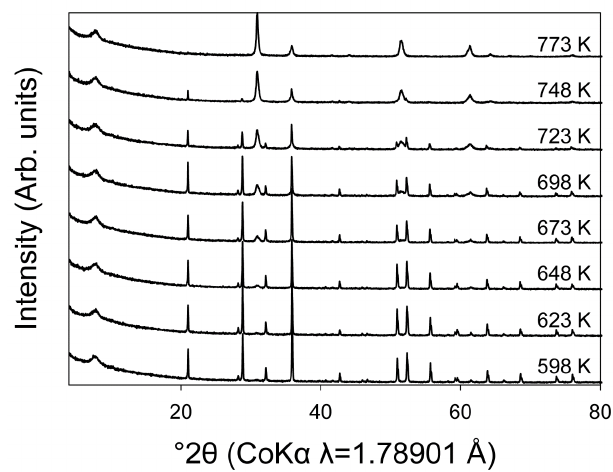
Figure 5. High temperature powder X-ray diffraction patterns from 598 K to 723 K. Bottom pattern is 598 K, and the patterns go up in 25° temperature increments. Bottom-most pattern exhibits only bastnäsite-(La). Top-most pattern exhibits only γ -LaOF. The middle six patterns exhibit both species as the decomposition reaction progresses from bastnäsite-(La) to γ -LaOF.